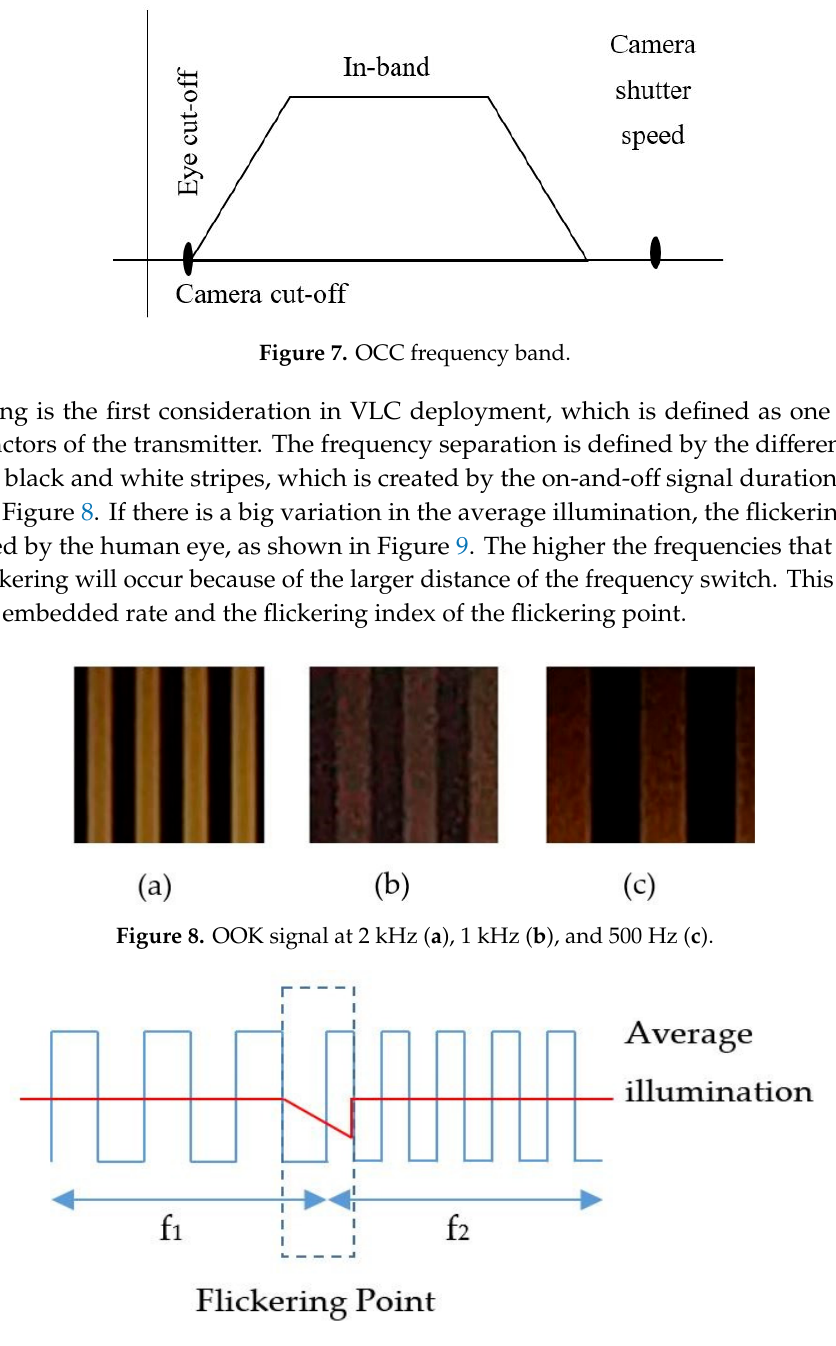
Figure 9. OCC Figure 9. OCC flickering. Figure 9. OCC flickering.